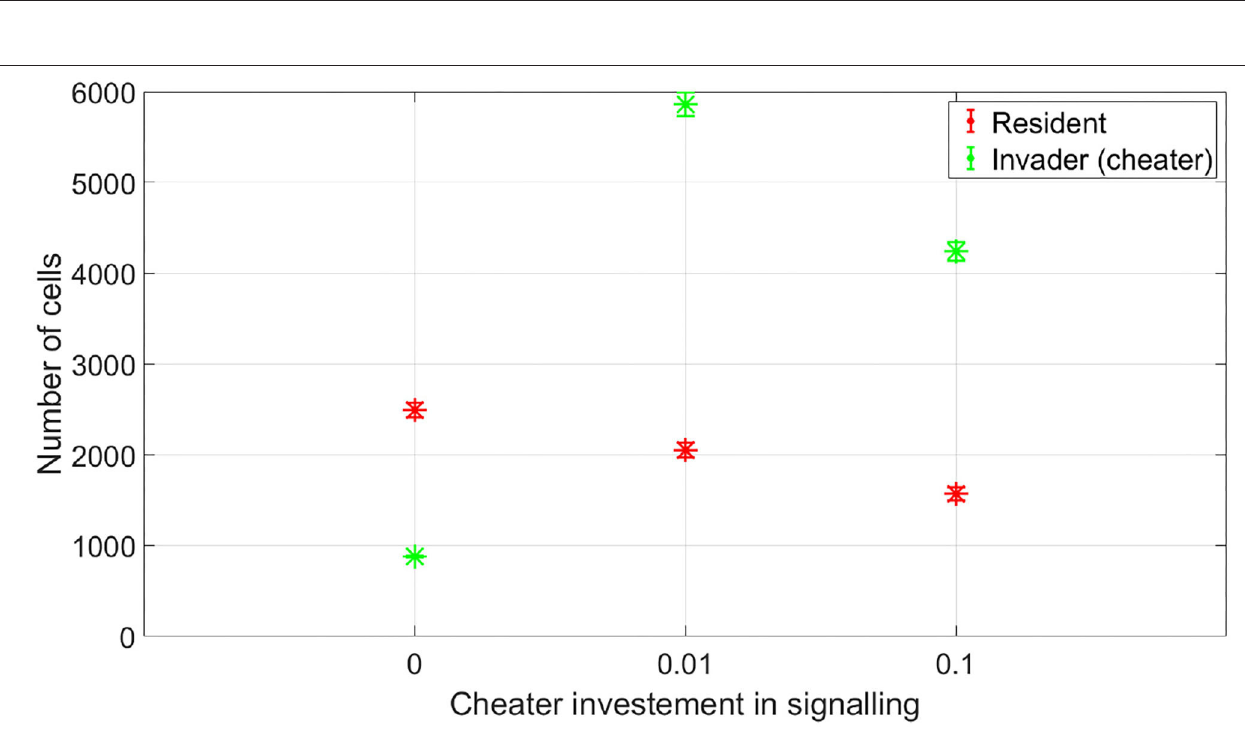
Frontiers in Microbiology |